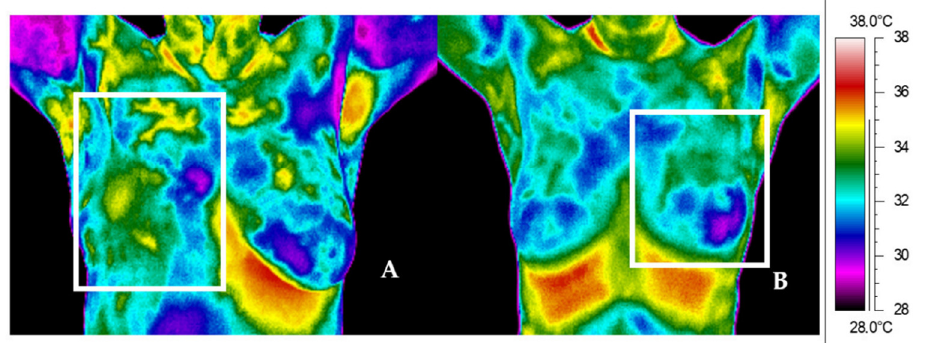
5 of 12 Figure 3. Thermal image of representative patient after surgery ( A ) and mastectomy ( B ) taken over 5 years after the end of radiotherapy treatment. The last presented Figure 3A,B includes thermal images for patients that were taken more than 5 years after RT. Figure 3A shows a thermogram for a patient after right breast surgery for whom the mean temperature value in the left breast was 33.3°C; however, the